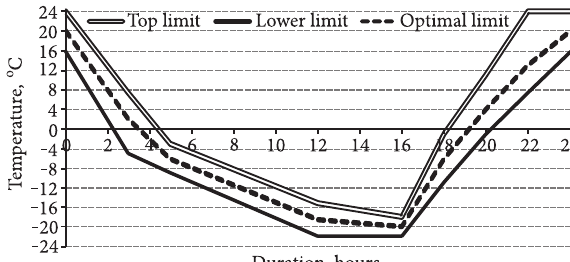
Fig. 1. The function of freeze-thaw cycles and temperature changes according to EN 1338/AC Annex D